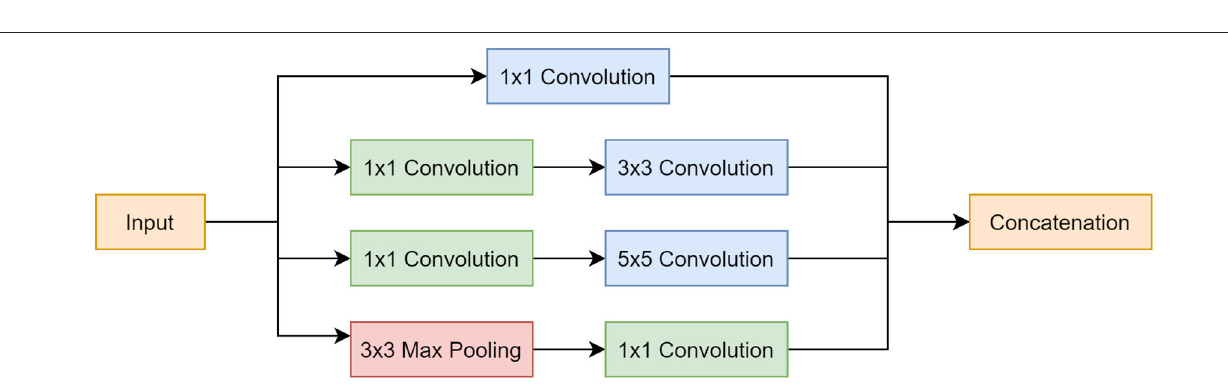
is employed to create weight values between 0 and 1,